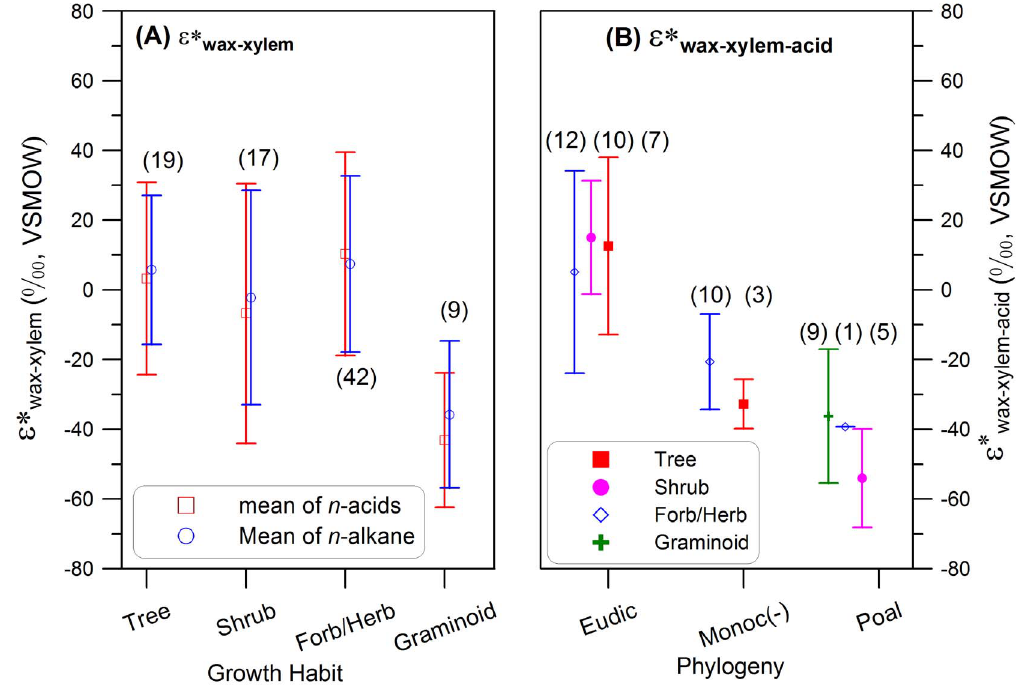
Figure 3. Comparison of * e wax-xylem values (scaled mean values): A) plants are classified by growth forms as shrubs, trees, forb/herb and graminoid; and B) plant are classified by their phylogenetic lineages including Poales, monocots (excluding Poales) and eudicots. The error bars show the 1 s standard deviation for all the species in individual lineages. Numbers on the charts denote the species numbers sampled for individual lineages or types.